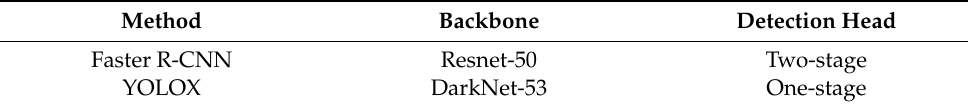
Table 5. Baseline object detection methods of UAV detection.